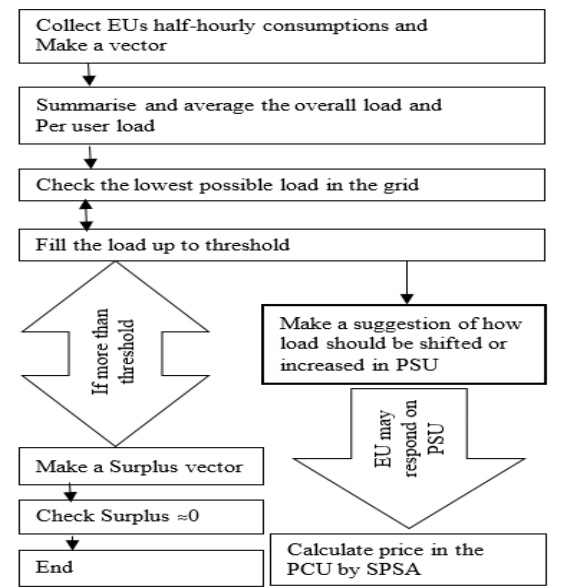
Figure 3. Proposed pricing model working